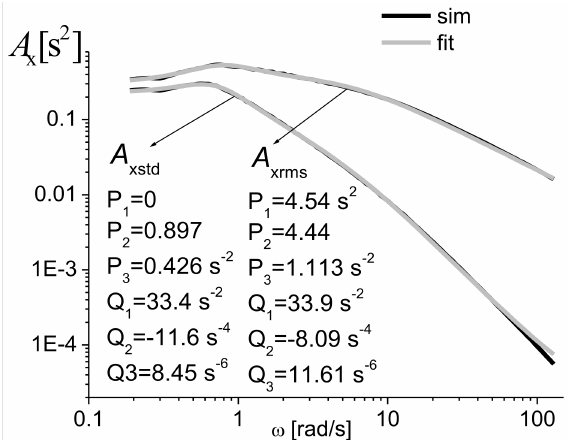
Figure 9. Simulated and fitted transmissibility factors for std and rms displacement.